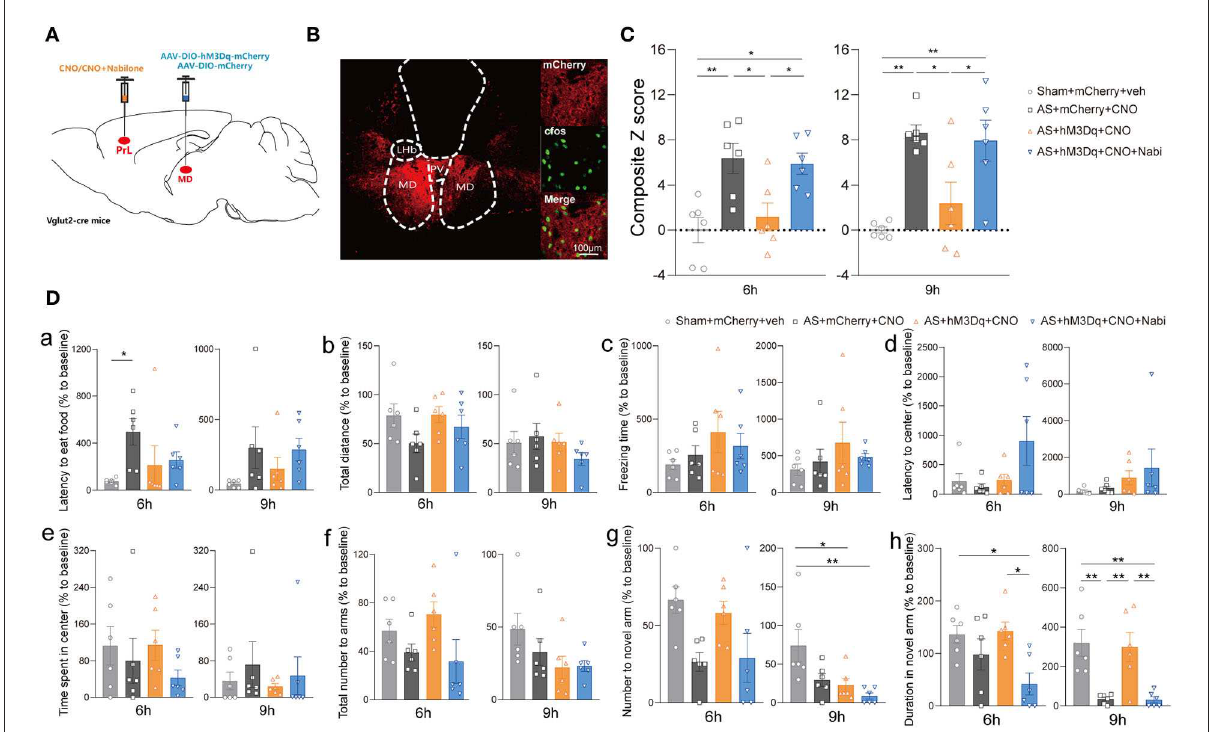
FIGURE5 The MD glu -PrL circuit was responsible for the effect of eCBs on POD. (A) Scheme of viral injection and CNO application. (B) The injection site (left) and activation efficiency (right). (C) The composite Z score at 6h (left) and 9h (right) after AS. (D) The latency to eat food in buried food test (a); the total distance (b), the freezing time (c), the latency to center (d), time spent in center (e) in the open field; the total number to arm (f), number to novel arm (g), duration in the novel arm (h) in Y maze at 6h (left) and 9h (right) after AS. Data are shown as mean ± SEM. N = 6. * P < 0.05, ** P < 0.01. AS, anesthesia and surgery; Nabi, nabilone; CNO, clozapine N-oxide; mCherry, AAV-DIO-mCherry; hM3Dq, AAV-DIO-hM3Dq-mCherry; PrL, prelimbic cortex; MD, mediodorsal thalamus.